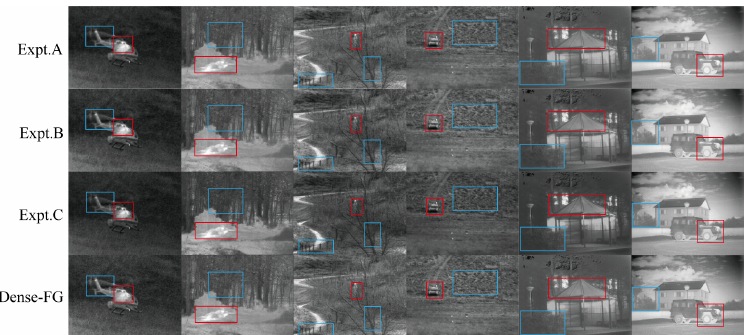
Figure 7. Partial results of ablation experiments. We label the infrared radiation information with a red box and the visible texture information with a blue box for clear comparison.